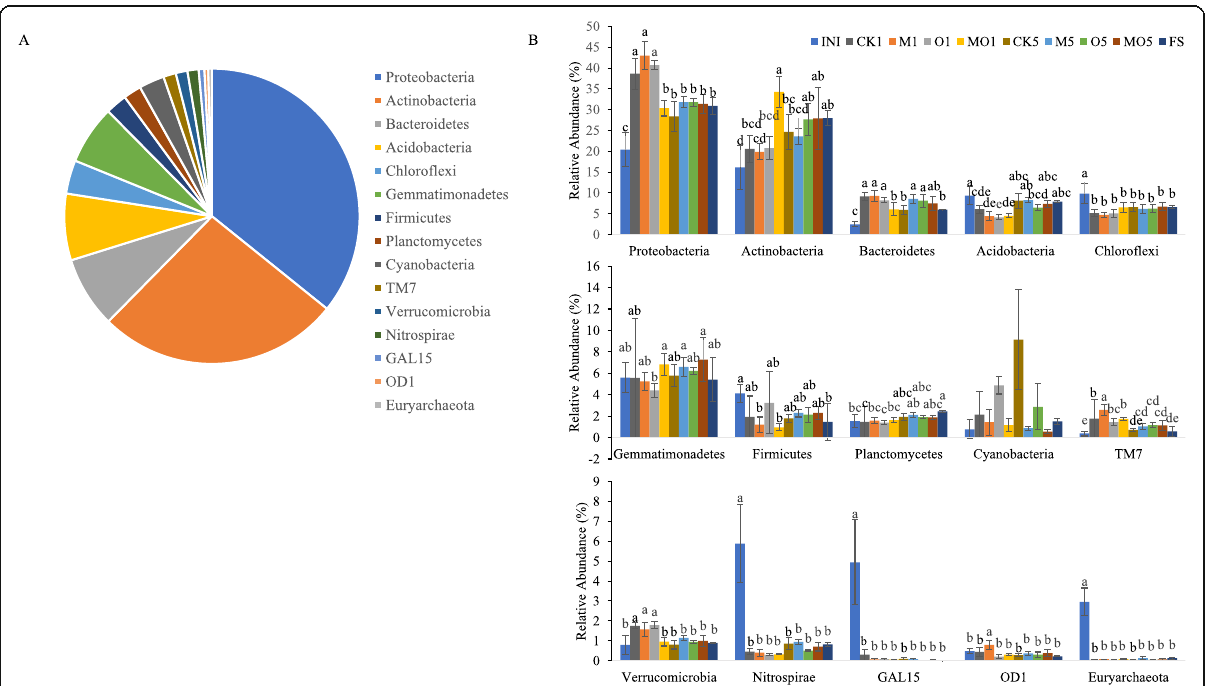
Fig. 1 The relative abundances of the 15 most prevalent bacteria at the phylum level in all samples combined ( a ) and in each treatment ( b ) Values followed by different letters are considered significantly different ( p < 0.05) according to Duncan ’ s multiple comparison